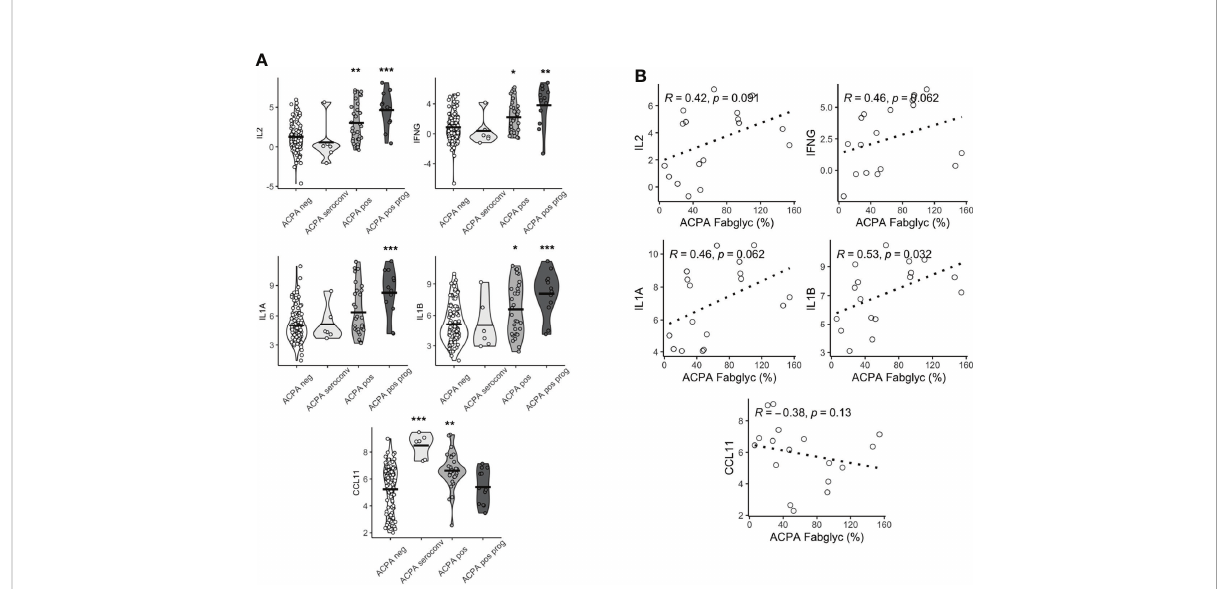
FIGURE 2 Baseline serum proteomics varies based on longitudinal outcomes. (A) Violin plots of CCL11, IFNG, IL2, IL1A, IL1B based on longitudinal outcomes, ACPA negative, ACPA seroconversion, ACPA positive and ACPA positive progression (prog). Analyzed by Dunn ’ s test adjusted by holm. ***p < 0.001, **p < 0.01, *p < 0.05. (B) Spearman correlation plots of IL2, IFNG, IL1A, IL1B and CCL11 and ACPA Fab glycosylation. ACPA, anti-citrullinated protein antibodies; Fab, variable domain region of IgG; CCL11, C-C Motif Chemokine Ligand 11; IFNG, Interferon gamma; IL1B, Interleukin 1 Beta; IL1A, Interleukin 1 Alpha; IL2, Interleukin